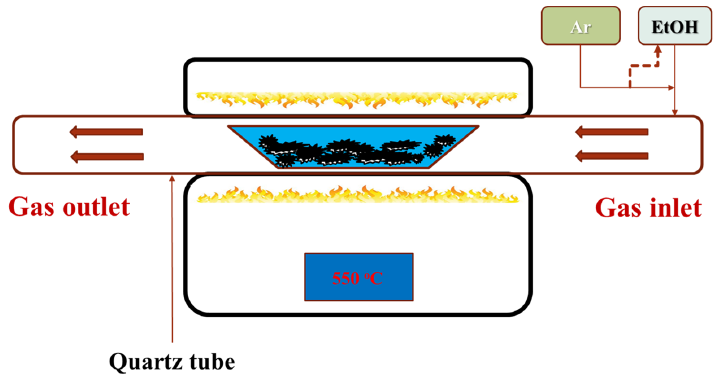
Figure 1. Scheme of the chemical vapor deposition (CVD) process.